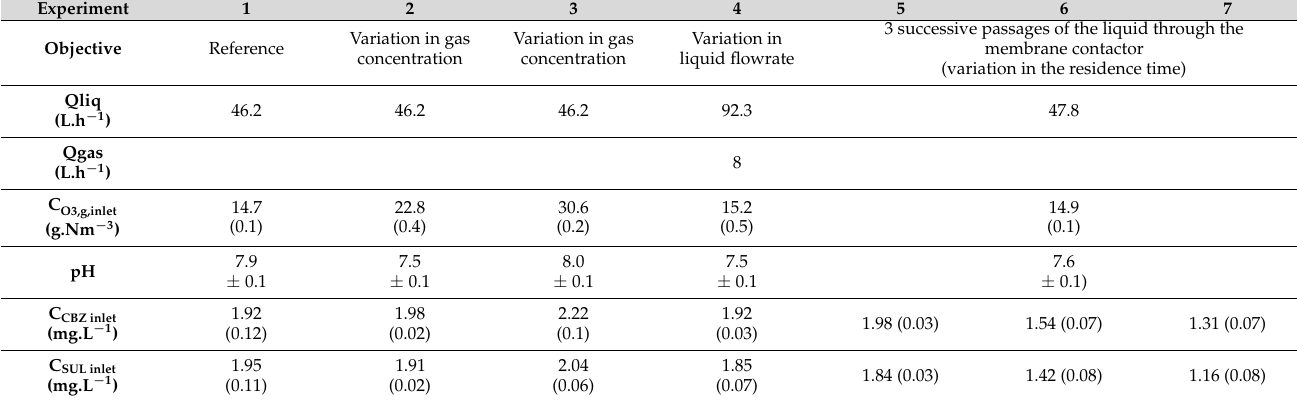
Table 5. Global parameters and objectives of the experiments with the targeted